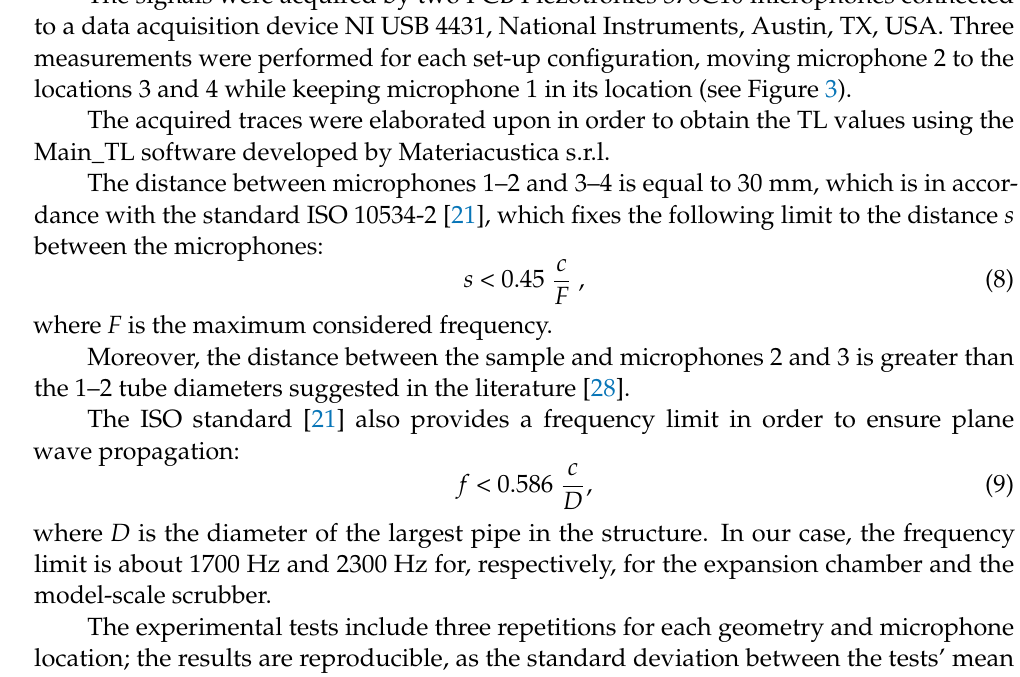
Table 2. Mesh quality